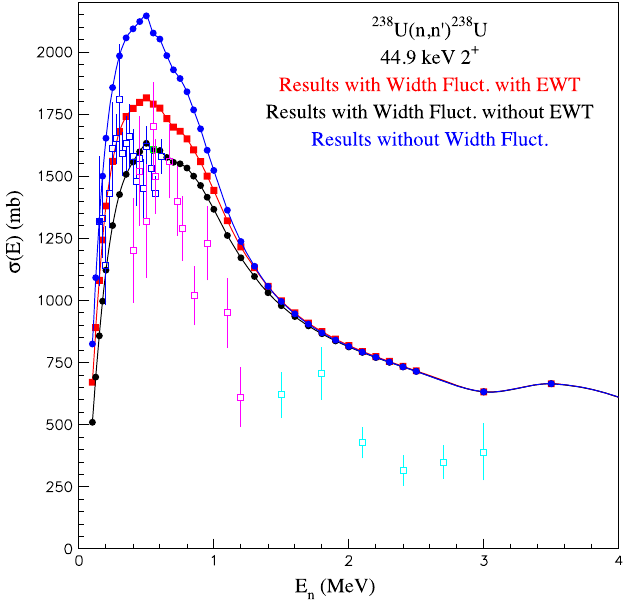
Fig. 6. Inelastic cross-section off the fi rst 2 + level of 238 U as function of the excitation energy E n . The red (resp. black) line shows the theoretical prediction obtained using (resp ignoring) the EWT with the Soukhovitski ~ i optical model potential [26]. The blue line shows the predictions obtained ignoring width fl uctuation corrections. Experimental data are taken from the EXFOR database [29].